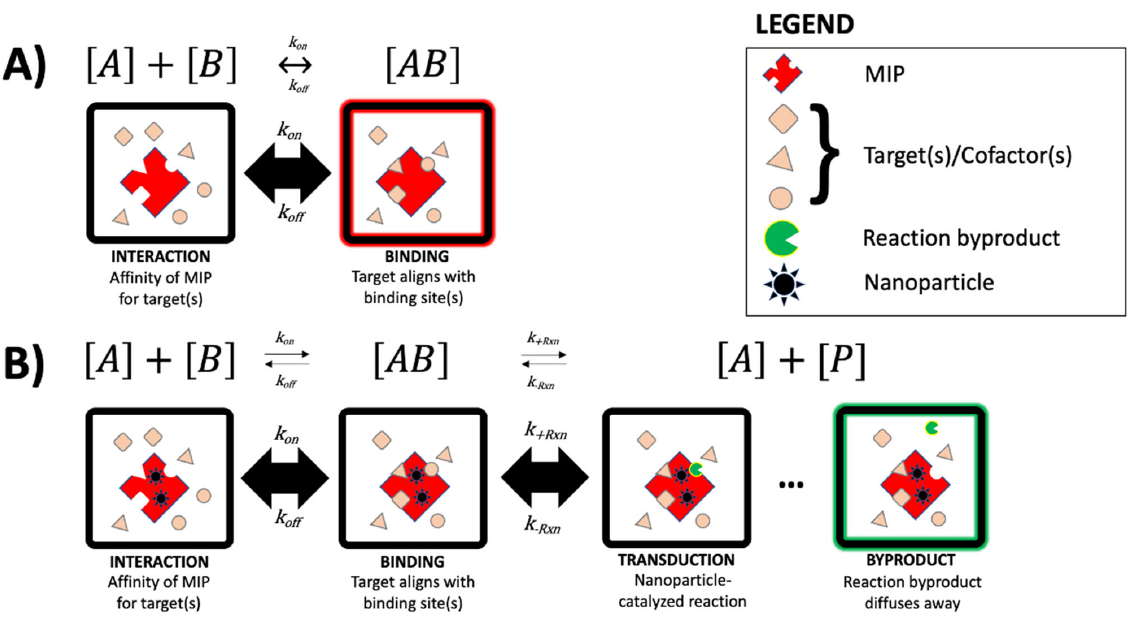
Figure 1. Particulate schematic of MIPS (top row) and nano-MIPS (bottom row), including an example of one kinetic model for each type of system. In this model, [A] represents a generic templated ligand (MIP), and [B] represents the molecular target. ( A ) Conceptual interaction between targets/cofactors and MIP. Signal is represented by a red halo, stoichiometrically shown as [AB]. ( B ) Conceptual diagram depicting nanoparticle-MIP ligand systems, where nanoparticle(s) serve as a reactive site. The signal is represented by a green halo, stoichiometrically shown as [P].